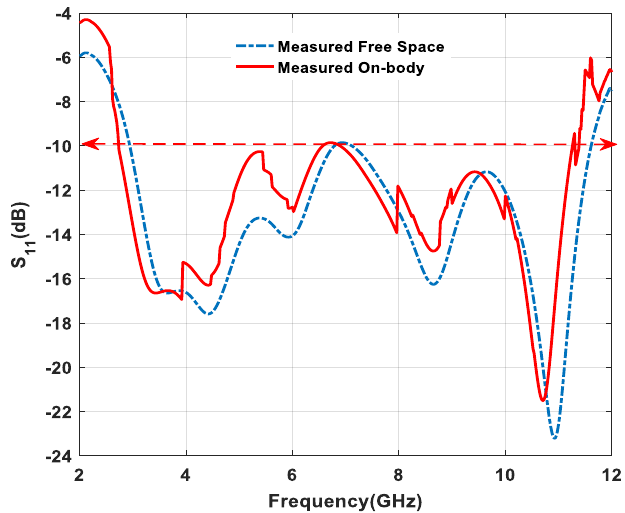
Figure 24. Measured return loss performance for free space and on body.